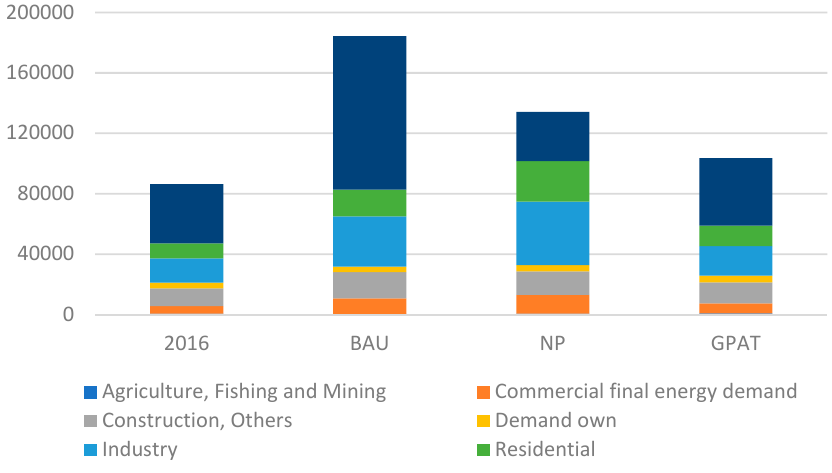
Figure 4. Distribution of energy demand by sector for 2016 and the Business as Usual (BAU), National Policies (NP) and Global Policies and Trends (GPAT) scenarios for 2030.